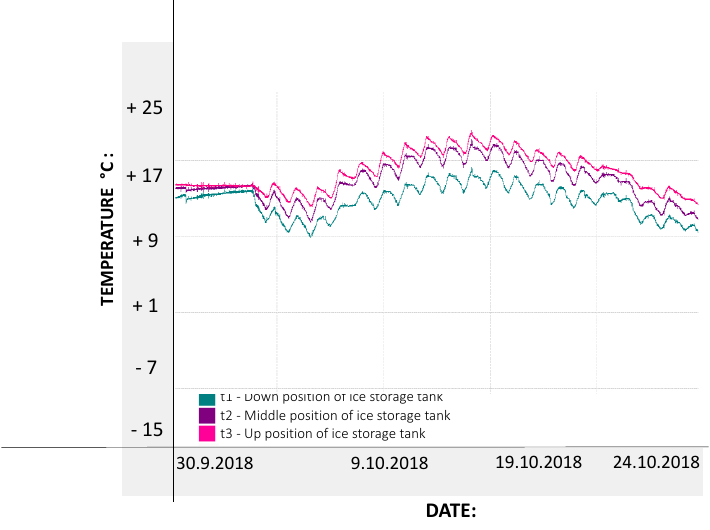
Figure 16. I. Phase—Normal waster stratification.